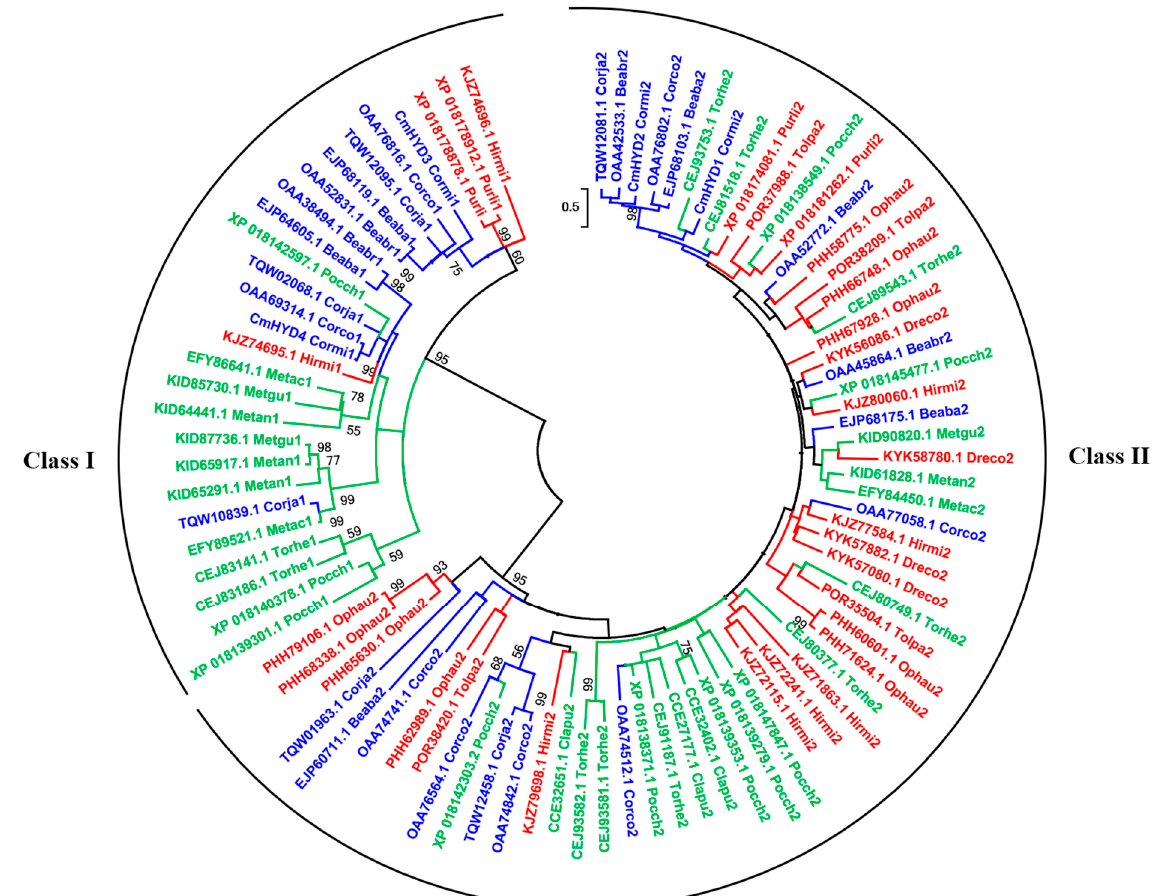
Figure 2. The phylogenetic analysis of hydrophobin proteins of Cordyceps . s.l. ML tree showing the phylogenetic relation- ships between selected fungal hydrophobins using a WAG + G + I model with MEGA X software. The analysis involved 90 hydrophobin protein amino acid sequences from Cordyceps . s.l. The tree with the highest log likelihood was − 9483.0859. Bootstrap support values above 50% are indicated next to the branches. Three families ( Cordycipitaceae ( blue ), Ophio- cordycipitaceae ( red ) and Clavicipitaceae ( green )) are presented in the tree. Fungal species are indicated with the following abbreviations: Beauveria bassiana , Beaba; Beauveria brongniartii , Beabr; Claviceps purpurea , Clapu; Cordyceps confragosa , Corco; Cordyceps javanica , Corja; Cordyceps militaris , Cormi; Drechmeria coniospora , Dreco; Hirsutella minnesotensis , Hirmi; Metarhi-